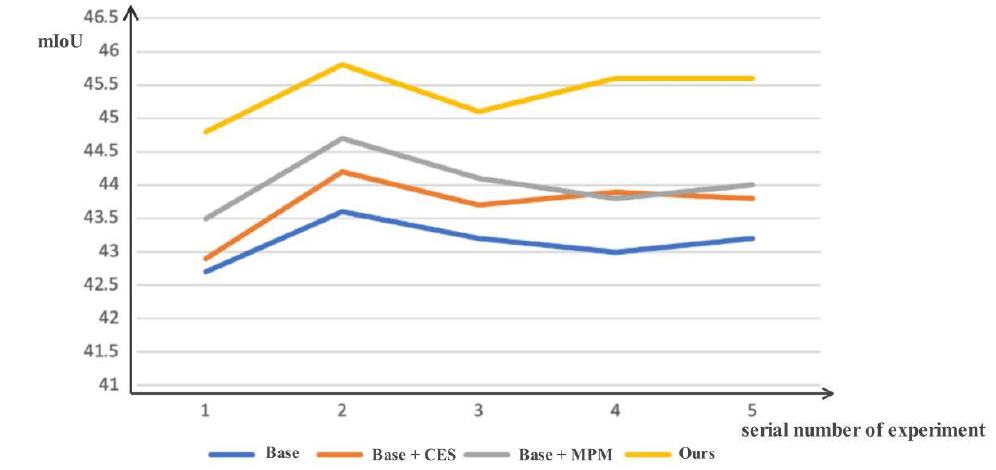
Figure 7. Five test comparisons of different